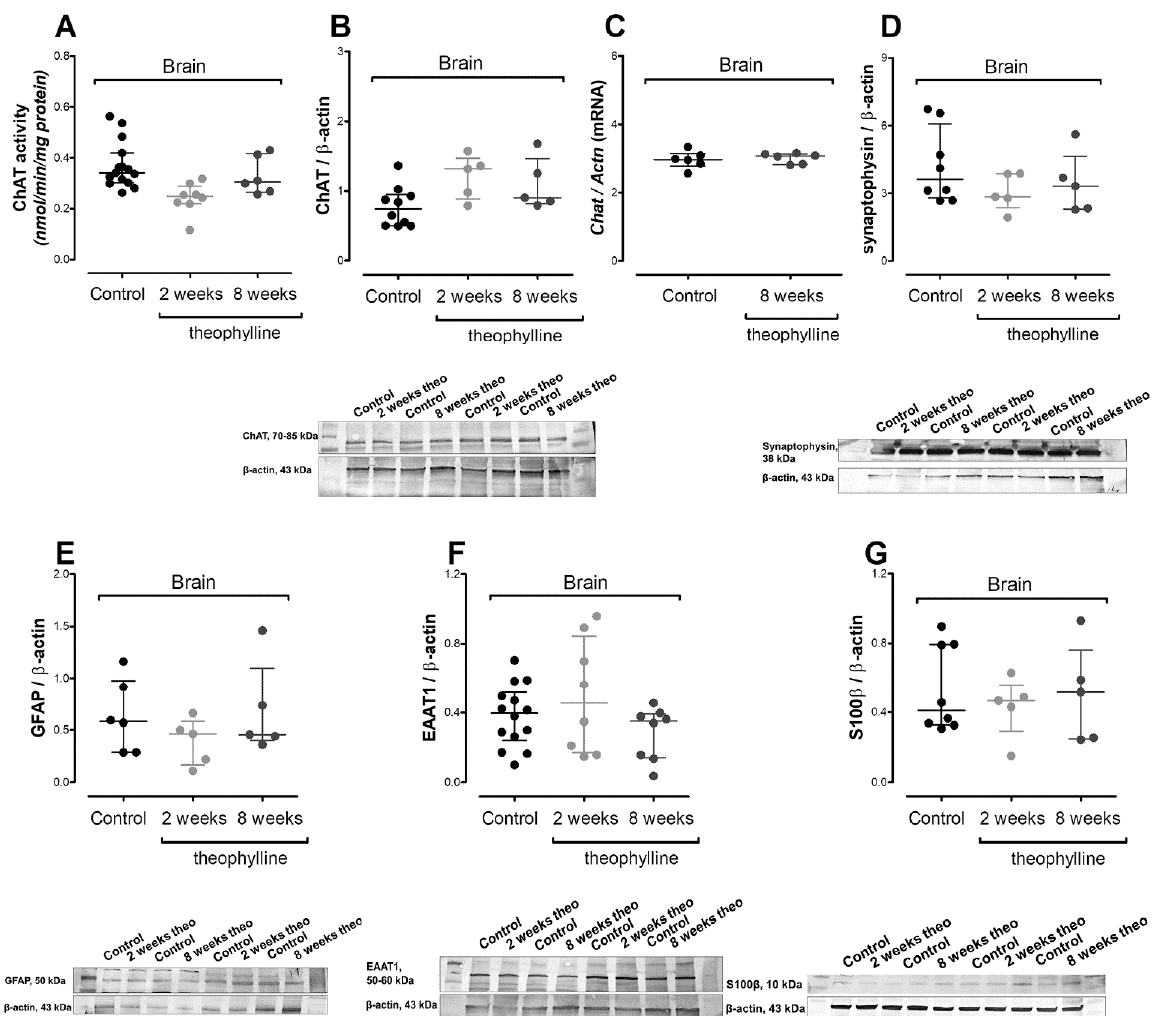
Figure 6. Impact of theophylline treatment on Wistar rat brain: ( A ) choline acetyltransferase (ChAT) activity; ( B ) choline acetyltransferase (ChAT) protein level; ( C ) choline acetyltransferase ( Chat ) mRNA level; ( D ) synaptophysin protein level; ( E ) glial fibrillary acidic protein (GFAP) level; ( F ) excitatory amino acid transporter 1 (EAAT1) protein level; ( G ) calcium binding protein β (S100 β ) protein level. Results are showed as medians with interquartile ranges from 5–15 observations per group.